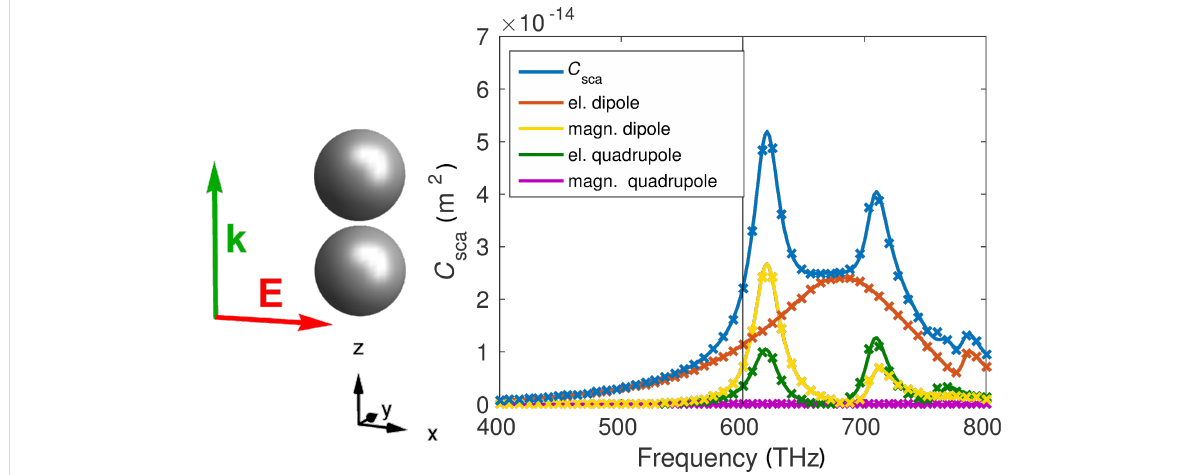
Figure 3: Total scattering cross section (blue) of the dimer and the contributions of different multipoles. The solid lines correspond to the semi-analyti- cal calculation based on the Mie coefficients of the spheres and the crosses correspond to the calculation with the FEM solver. We observe an excel- lent visual agreement. The black vertical line shows the spectral position that is used for further calculations to show the T-matrix entries. 10 addition- al plane wave illuminations were used for the numerical T-matrix calculation. On the left side we display the geometry and illumination direction of the dimer setup. Note that this illumination is only relevant for this particular cross section calculation and the T-matrix is generally independent of the illu- mination.